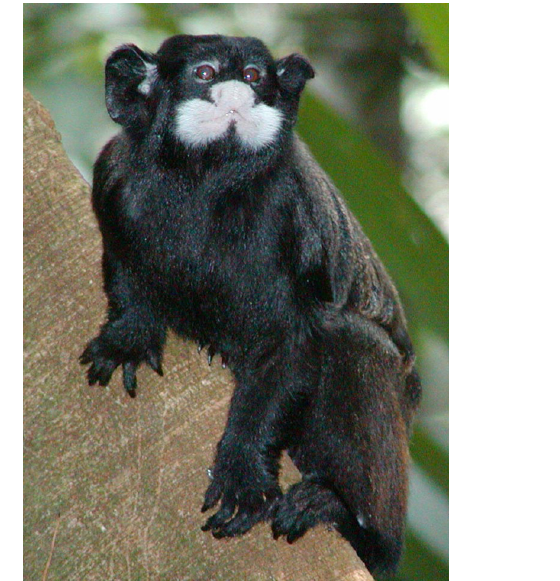
Figure 1. Moustached tamarins, Saguinus mystax , were the fo- cal species of the first DPZ field study in 1985–1986 (Photo ©Julia Diegmann and Eckhard W.